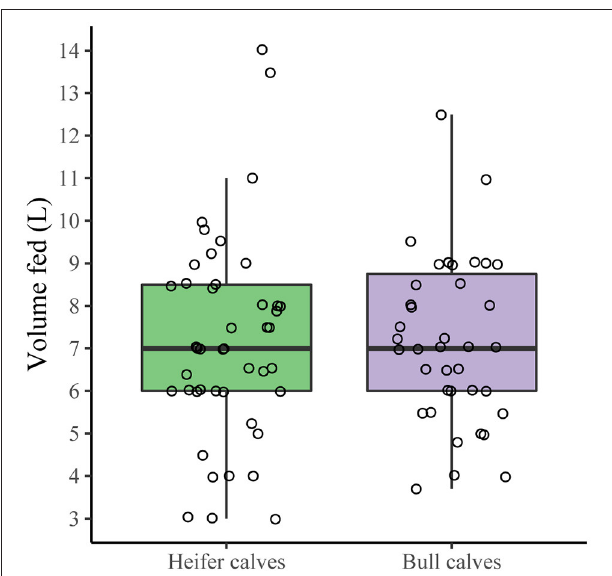
FIGURE 5 | Total volume of colostrum fed to heifer calves and bull calves. Across all farms that provided colostrum manually for all three feedings ( n = 84), no difference in total volume of colostrum fed was found between heifer and bull calves ( p = 0.94, Wilcoxon rank sum